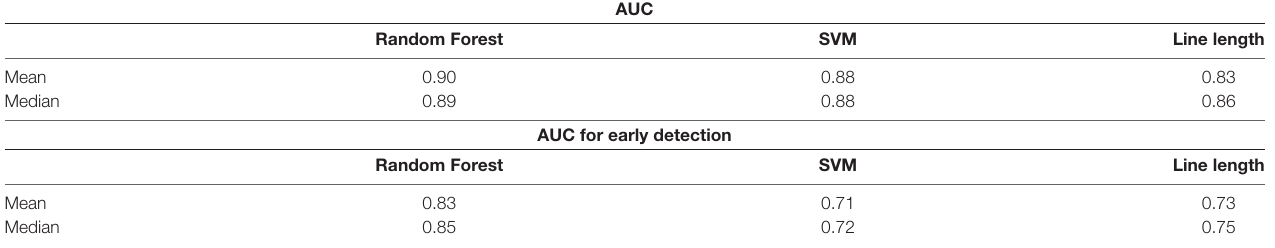
TABLE 1 | Comparison of the area under the receiver operating characteristic (ROC) curve (AUC) over all the patients between the classifiers in a single-channel mode.